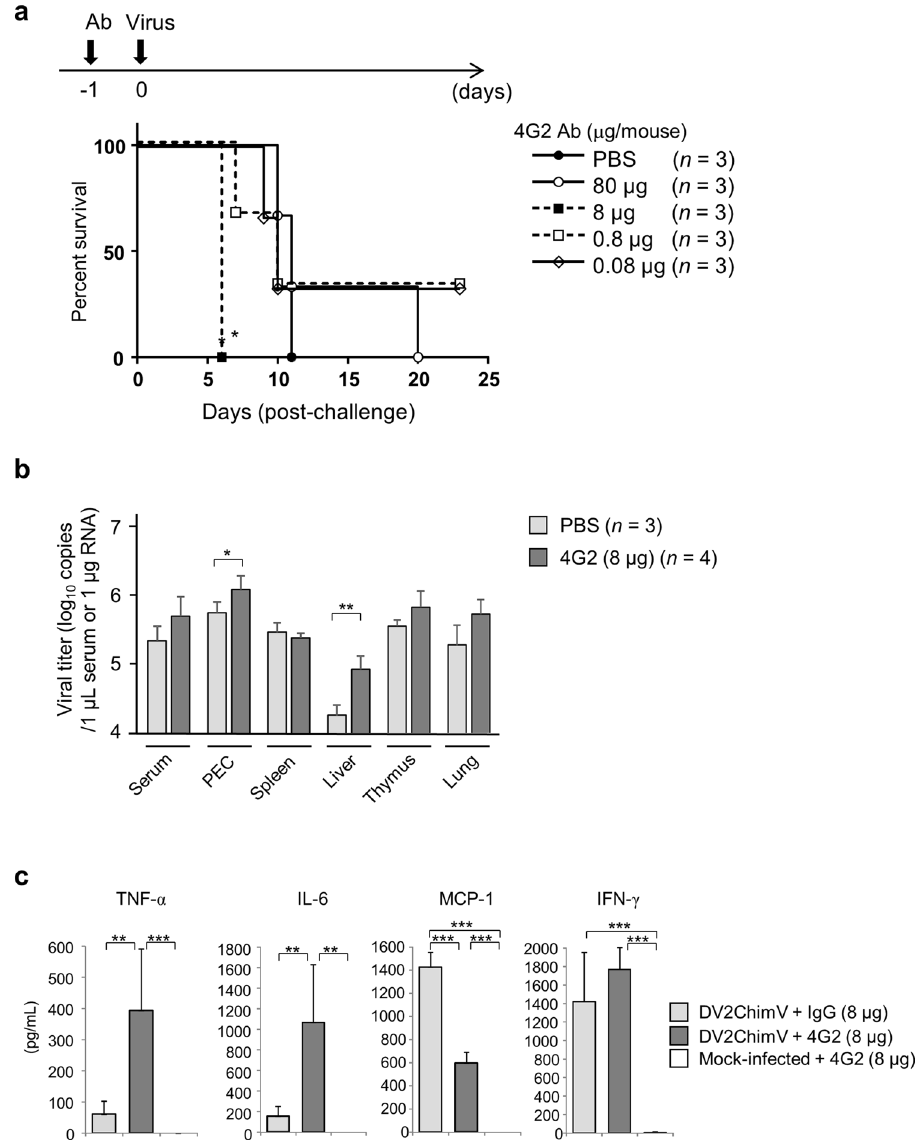
Figure 5. Antibody-dependent enhancement (ADE) in mice. ( a ) IFN-α/βR–γR dKO mice ( n = 3 per group) were inoculated with 0.08–80 µg per animal of the mouse monoclonal antibody (Ab) to dengue virus E-protein, 4G2, 24 h prior to infection with 8.0 × 10 2 focus-forming units (FFU) of DV2ChimV chimeric flavivirus. Kaplan–Meier survival curves show the percentage of mice surviving at the specified days post-infection, and were analyzed by the log rank (Mantel–Cox) test. Survival rates were significantly different between mice administered with 8 µg 4G2 and those treated with PBS (* P < 0.05). ( b ) Mice treated with 8 µg 4G2 ( n = 4) and those treated with PBS ( n = 3) were euthanized under anesthesia at day 5 p.i., and viral levels in tissues were measured by qRT-PCR. The graph shows mean values and standard deviation. Statistical differences in viral titers in each organ between mice treated with 4G2 and those treated with PBS were calculated using the Unpaired T-test after log transformation. * p < 0.05, * p < 0.01 ( c ) Levels of inflammatory cytokines in the serum of treated mice. IFN-α/βR–γR dKO mice were inoculated with 80 μg 4G2 ( n = 4) or 80 μg control IgG ( n = 3) 24 h prior to infection with 8.0 × 10 2 FFU of DV2ChimV. IFN-α/βR–γR dKO mice were inoculated with 80 μg 4G2 and mock-infected ( n = 5). At Day 5 p.i., serum samples were collected for analysis by flow cytometry. Levels of TNF-α, IL-6, MCP-1, and IFN-γ in serum samples were determined with the Mouse Inflammation Cytometric Bead Array Kit. Results are expressed as mean + SD of triplicate experiments. Levels of cytokines and chemokines were analyzed by one-way ANOVA. Significance of the levels was assessed by Tukey’s Multiple Comparison Test. ** P < 0.01; *** P <